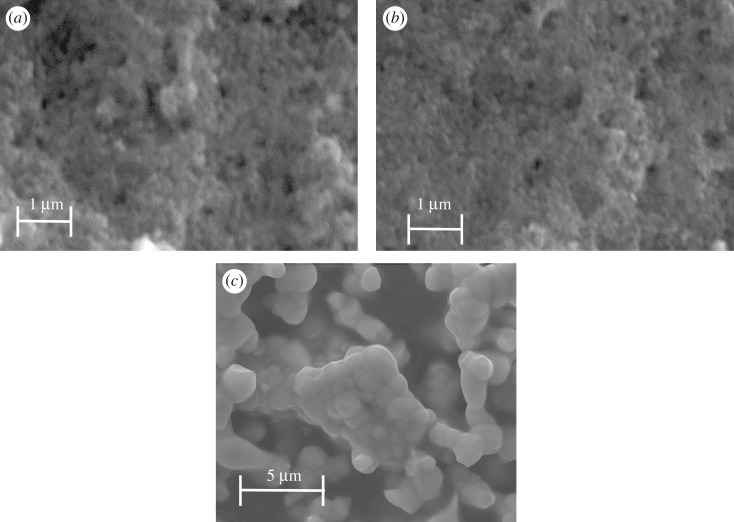
SEM images of (a) TiO2, (b) TiO2/Y1.86Eu0.14WO6 (100:2.5) and (c) Y1.86Eu0.14WO6.